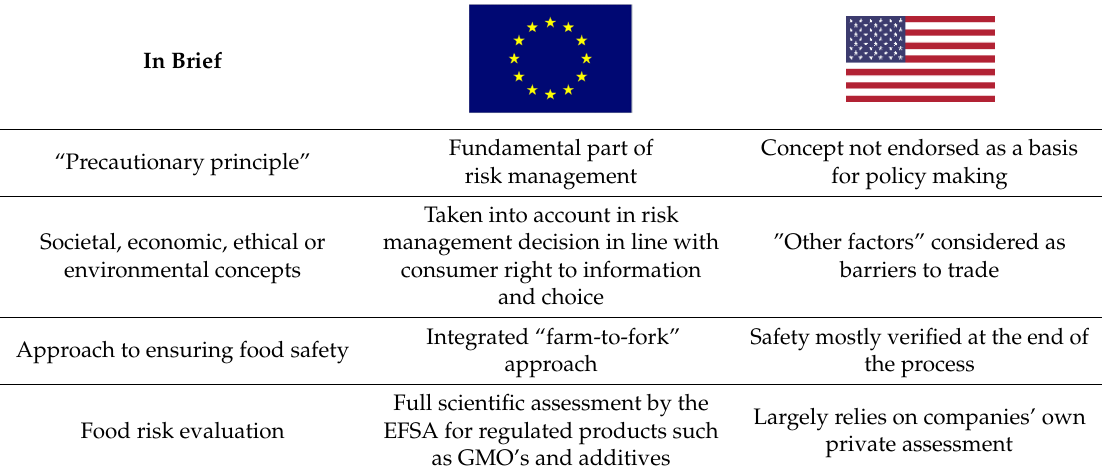
Table 1. Comparison key elements of the EU–US food regulatory